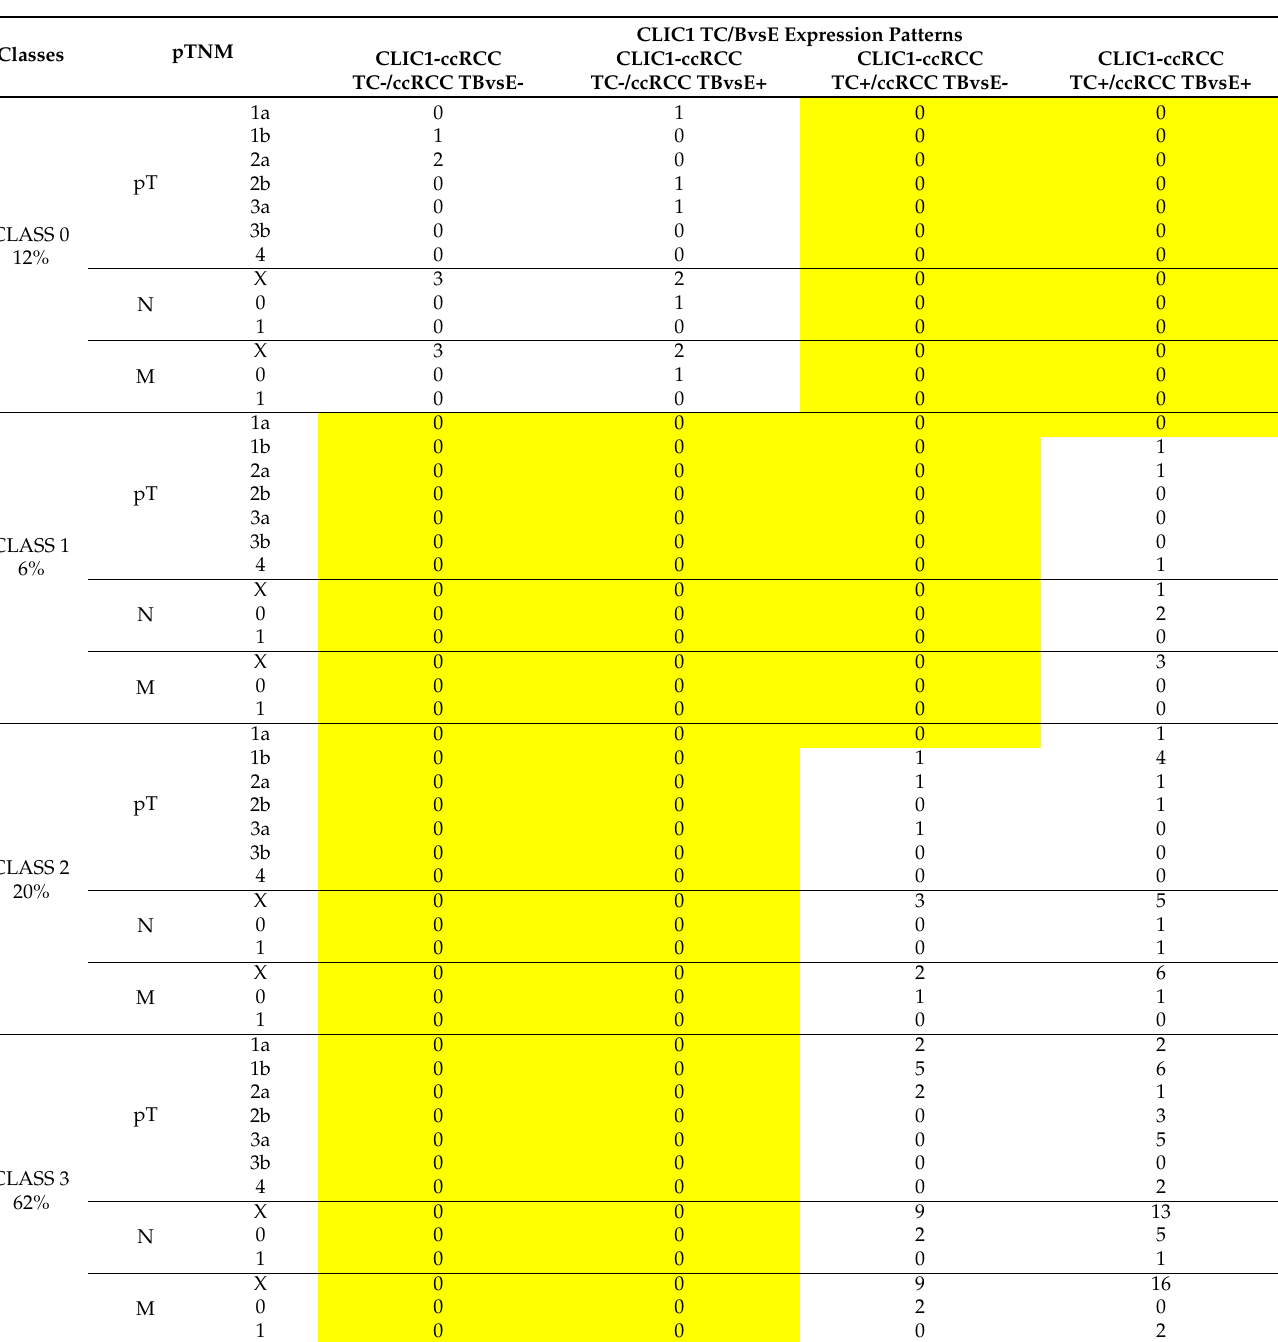
Table 3. Number of ccRCC cases from each class reported in correlation with the CLIC1 TC/BvsE expression pattern corresponding to each of the pT stages, as well as the N and M parameters. Yellow highlighted columns point out negative cases. In this way, we may observe that the number of cases with CLIC1 co-expression in both tumor and endothelial cells increases from class1 to class 3, with most of the cases being evaluated as exhibiting pT 2a, 2b, 3a, 3b, and